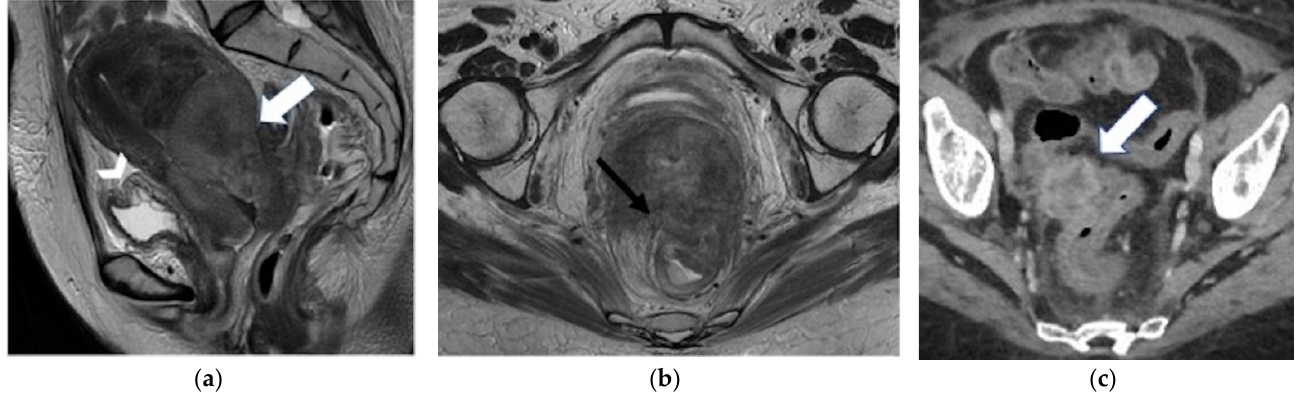
Figure 6. ( a , b ) A 46-year-old patient who underwent chemoradiation therapy for recent cervical cancer. ( a ) Sagittal and ( b ) axial FSE T2-weighted images show a soft-tissue mass in the cervix, extended posteriorly to the rectal wall (white arrow), causing luminal narrowing (black arrow). Note the bullous oedema of the posterior bladder wall mucosa (arrowhead). ( c ) A 58-year-old patient who underwent radical hysterectomy with BSO and chemoradiation therapy for cervical cancer. Axial post-contrast CT image shows a nodular mass in the right pelvis infiltrating the distal sigma (arrow).